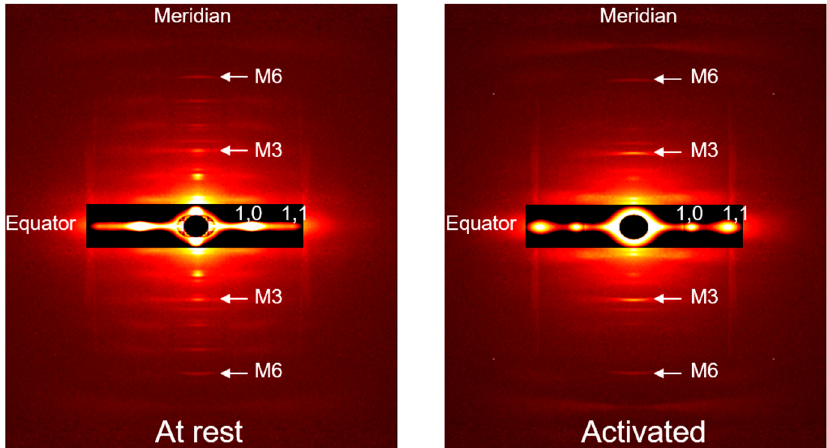
Figure 7. X-ray reflection patterns of a fibre bundle in the passive condition (at rest) and in the active condition (activated). Equatorial reflections 1,0 and 1,1 and meridional reflections M3 and M6 are indicated. Bundles were exposed to individual X-ray exposures of 0.5 s in total, and the X-ray patterns were collected as a continuous series of 18 ms frames separated by 2 ms in order to minimize radiation damage.